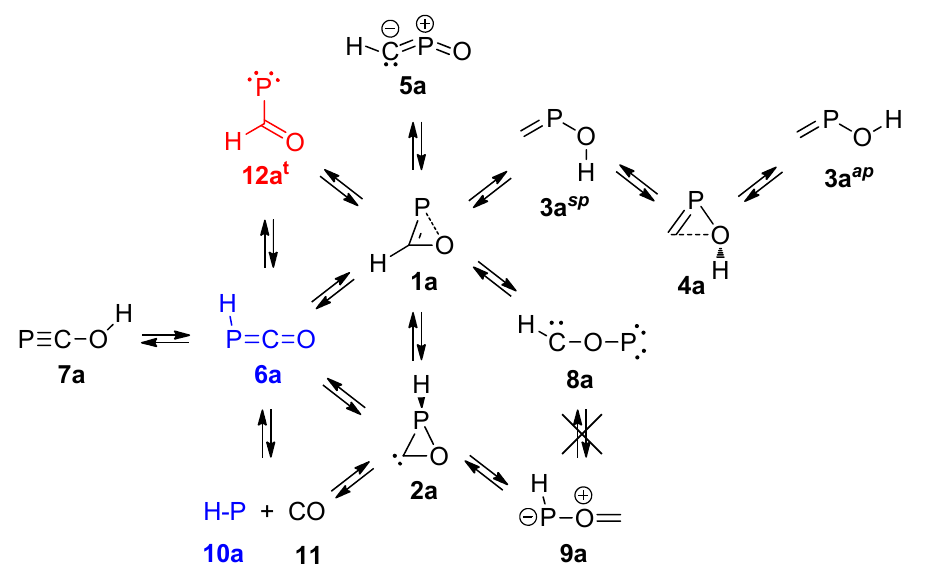
Scheme 2. Isomers derived from parent oxaphosphirene 1a . Singlet (closed-shell) structures represented in black, triplet ones in red, and those that were found in both electronic states are in